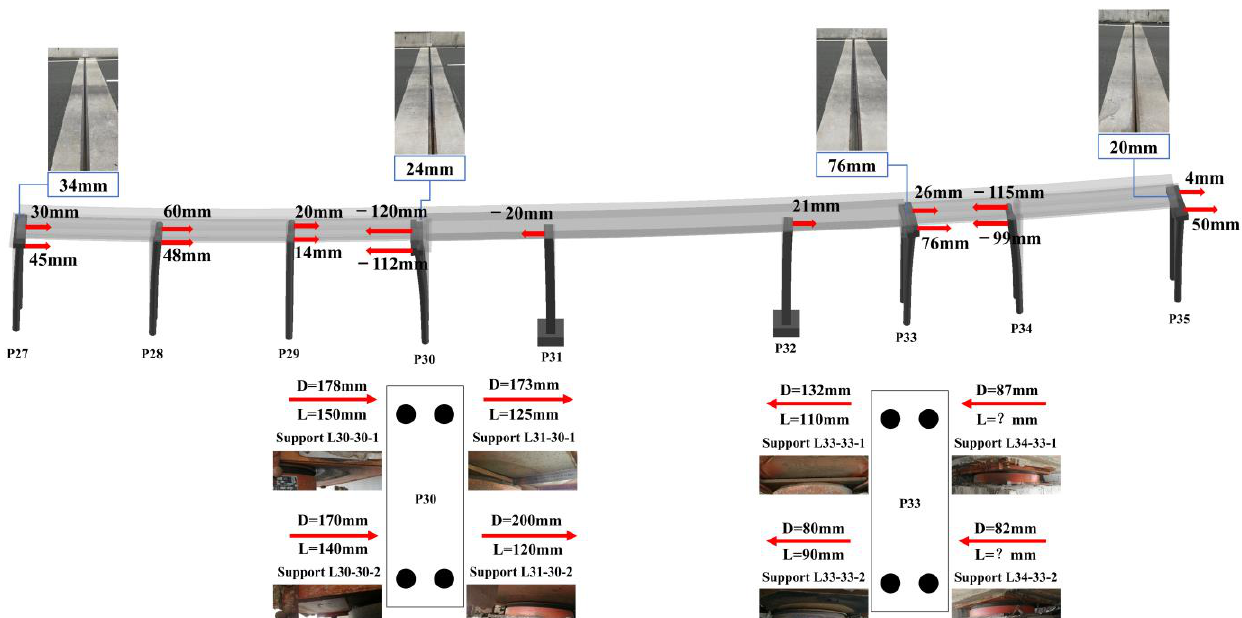
Figure 8. Disease investigation data of the ramp bridge.